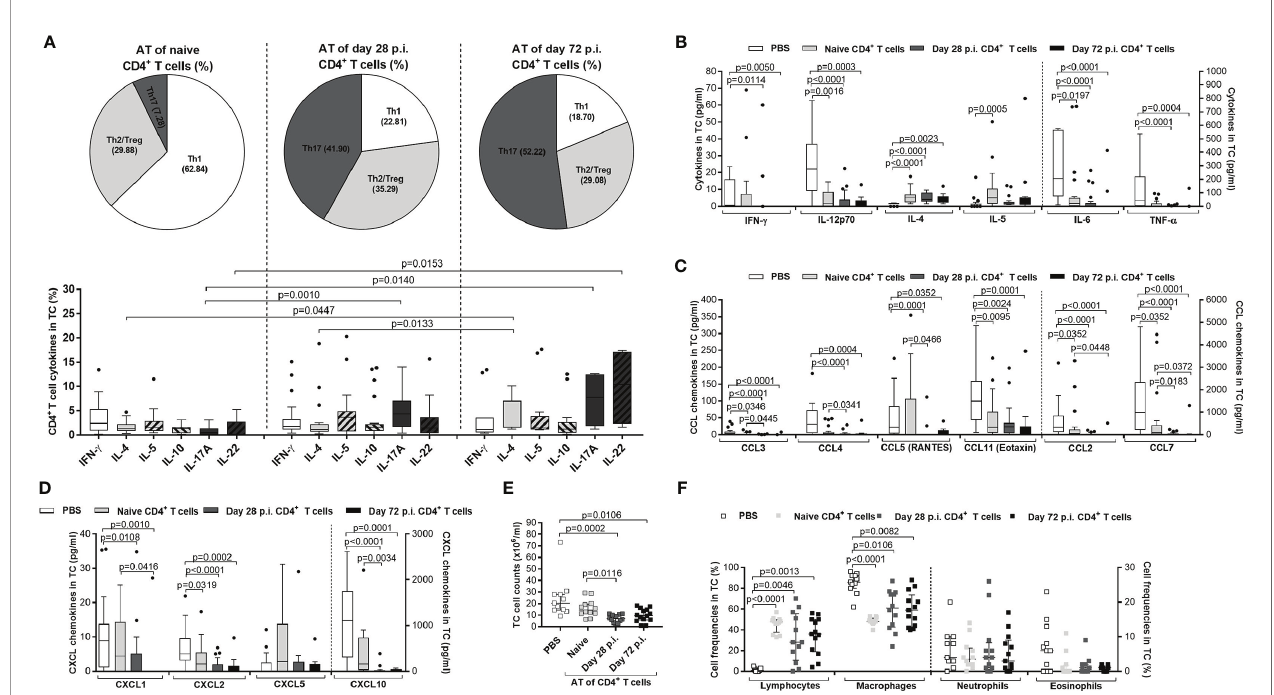
FIGURE 7 | Immune pro fi le of transferred CD4 + T cells in L. sigmodontis -infected RAG2IL-2R g -/- mice. On day 72 p.i., CD4 + T cells and immune responses in the thoracic (TC) were analysed from L. sigmodontis -infected RAG2IL-2R g -de fi cient C57BL/6 mice. Therefore, CD4 + T cells that were either adoptively transferred from naïve, or L. sigmodontis- infected (day28 or day 72 p.i.) C57BL/6 donor mice were isolated and analysed for cytokine secretion patterns in the (A) TC using fl ow cytometry. Moreover, (B) cytokine and (C, D) chemokine levels were also analysed in the TC. Finally, (E) total TC cell counts and (F) frequencies of lymphocytes, macrophages, neutrophils and eosinophils were analysed using cytospin technique. Graphs show (A) pie charts, (A – D) box and whiskers and (E, F) dot blots with median and interquartile ranges. Graphs show (A) four independent experiments including adoptive transfer of CD4 + T cells from naïve donor mice (n= 24) or donor mice that were infected with L. sigmodontis for 28 days (n=21) or 72 days (n=13), (B – D) 6 independent experiments including no adoptive transfer (PBS; n=25) and adoptive transfer of CD4 + T cells from naïve donor mice (n= 22) or donor mice that were infected with L. sigmodontis for 28 days (n=21) or 72 days and (E, F) 2 independent experiments including PBS (n=11) and adoptive transfer of CD4 + T cells from naïve donor mice (n= 12) or donor mice that were infected with L. sigmodontis for 28 days (n=12) or 72 days (n=14) into RAG2IL-2R g -de fi cient C57BL/6 mice. Signi fi cant differences between the groups were determined by Kruskal-Wallis-test followed by a Dunn ’ s multiple comparison test. AT, adoptive